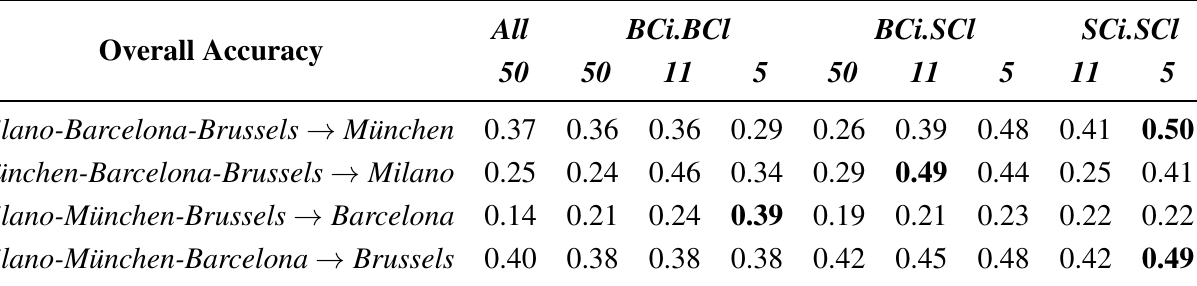
Table 5. Overall accuracy obtained by multiple models trained with different numbers of predictors and